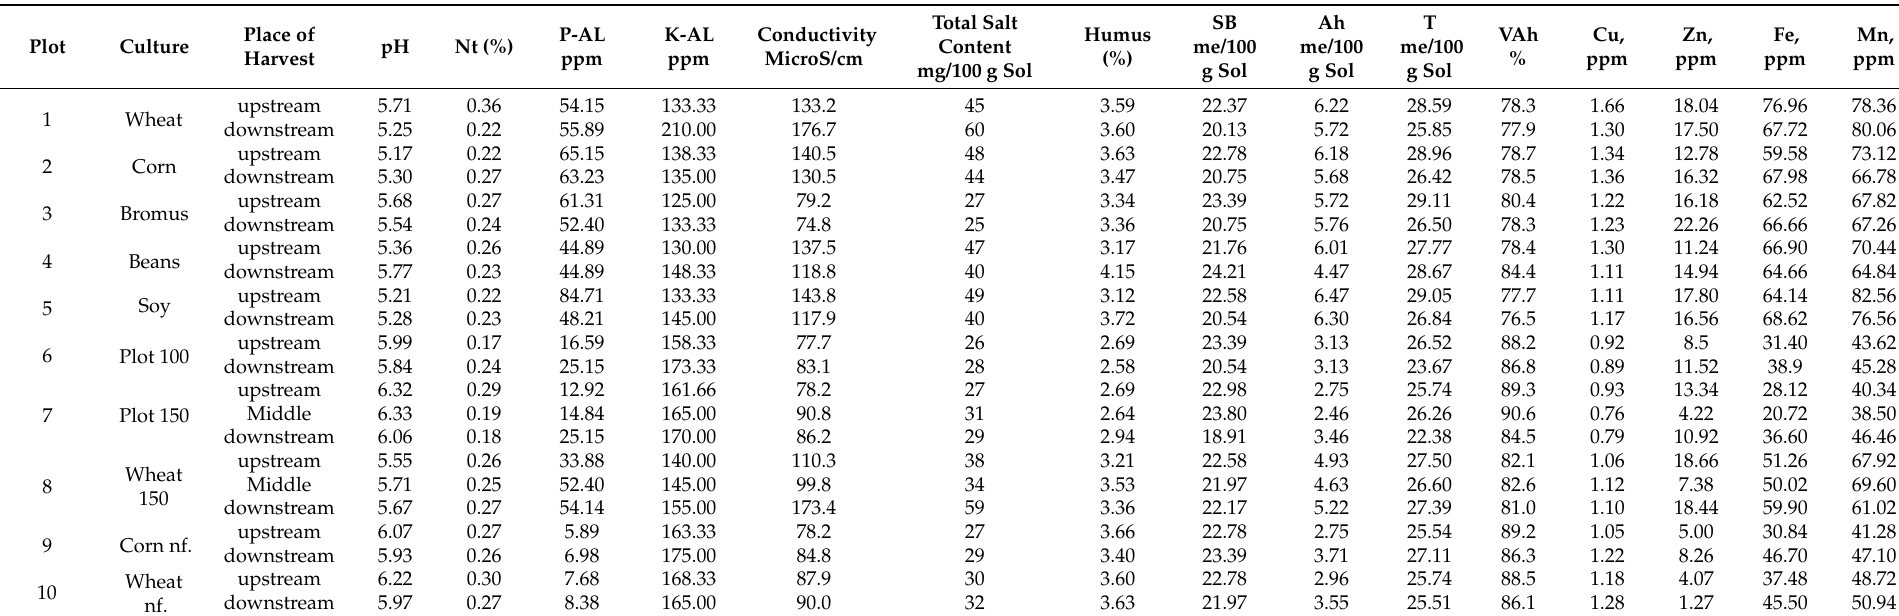
Table 2. Analytical results regarding the level of nutrient supply at the standard nutrient leakage control plots, SCDCES—MM